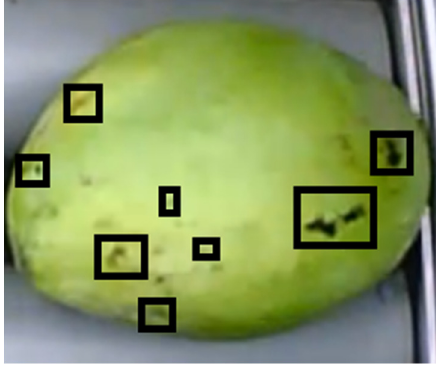
Figure 6. Defects of mango’s surface.